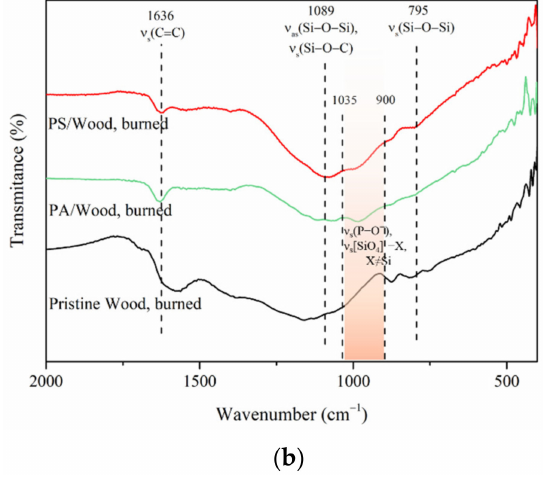
Figure 11. ( a ) Digital photos, SEM micrographs ( × 100 magnification) and ( b ) FTIR spectra of the char residues after